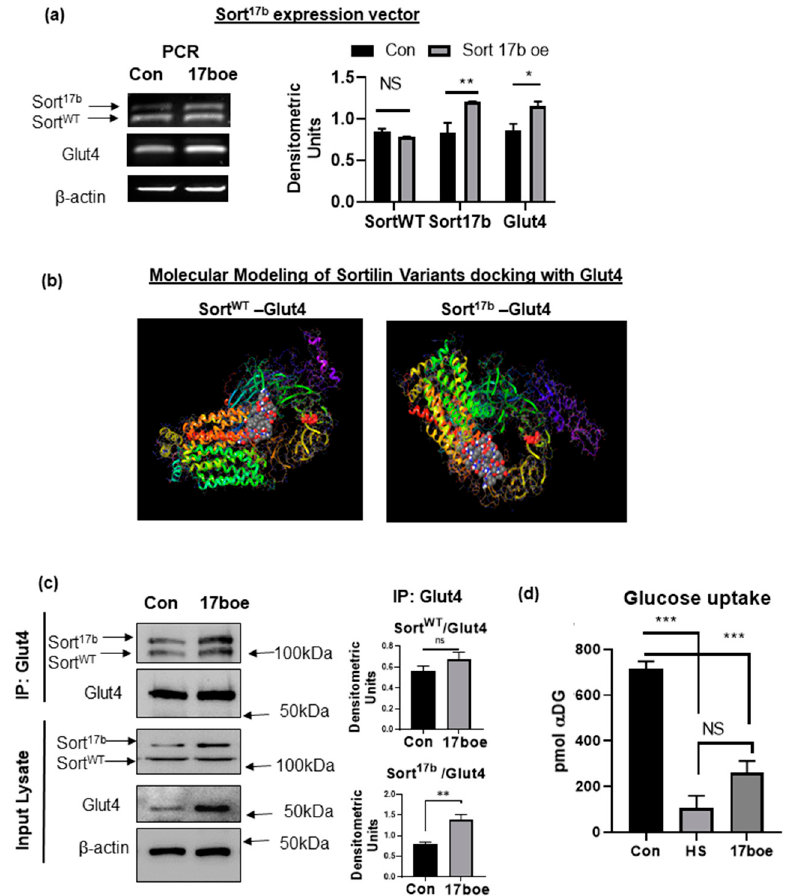
Figure 6. Sort 17b binds robustly to Glut4 ( a ) Sort 17b expression vector was transfected in 3T3L1 preadipocytes for 48 h (17boe sample) or day 2 control (Con sample). Total RNA was isolated, PCR was performed using primers specific to sortilin exon 17 (sense) to exon 19 (anti-sense) to simultaneously detect both sortilin variants. The PCR products were separated on a 1% agarose gel, visualized using ethidium bromide staining and normalized to β -actin expression ( n = 5). Graph represents densitometric units representative of 5 experiments performed independently. Statistical analysis was performed by two tailed t -test; * p < 0.05, ** p < 0.01 between control and Sort 17b over-expressing (17b oe) samples. ( b ) Molecular dynamics was performed to elucidate binding of Sort WT or Sort 17b to Glut4. Equilibrated and minimized Glut4, Sort WT and Sort 17b proteins were docked to the equilibrated and minimized Glut4 protein. Docking results show binding of Sort WT as well as Sort 17b to the first luminal loop of Glut4. Transmembrane helices of Glut4 are seen on the left, the first luminal domain of Glut4 is indicated by ball model, and sortilin’s luminal 10 blade propeller domain can be seen on the right with the C-terminal tail in purple. ( c ) Sort 17b expression vector was transfected in 3T3L1 preadipocytes for 48 h (17 boe sample) or day 2 control (Con sample). Coimmunoprecipitation assay was performed by using Glut4 antibody for immunoprecipitation. Western blot analysis was then performed on the immunoprecipitated (IP) samples using antibodies against sortilin or Glut4 as indicated in the figure. Graphs show densitometric analysis of individual sortilin bands normalized to Glut4 ( n = 5). Simultaneously, the input lysate was analyzed by western blot using antibodies against sortilin or Glut4 ( n = 5). Statistical analysis was performed by two tailed t -test; ** p < 0.01 between control and Sort 17b over-expressing (17b oe) samples. ( d ) 3T3L1 pre-adipocytes were differentiated and, on day 4, adipocytes were treated with high serum (HS) to induce insulin resistance or transfected with Sort 17b expression vector (17boe sample) for 48 h. Insulin stimulated glucose uptake assay was performed and uptake of α - deoxy glucose ( α DG) was measured; no α DG and lysed cells were used as controls ( n = 5). Statistical analysis was performed by one-way ANOVA; *** p < 0.001 between no treatment and insulin treated cells in control and high serum (HS) samples or control and Sort17boe sample. Ns = not